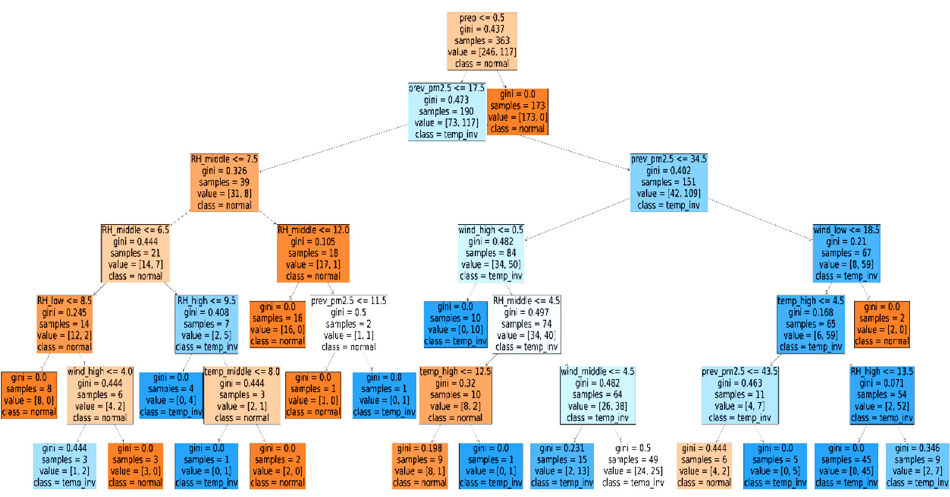
Figure 6. The learned decision tree from the collected data in 2016.